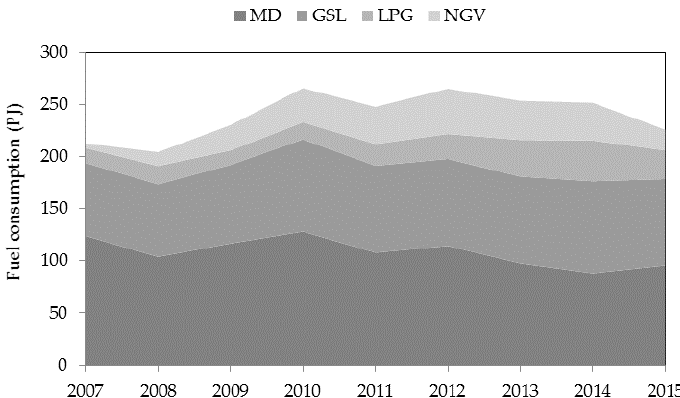
Figure 3. Fuel consumption of on-road transport activity in the BMR area from 2007 to 2015. Remark: MD stands for diesel (including HSD, HSD-B5, and LSD); GSL stands for gasoline fuel (including ULG-RON 91, ULG-RON 95, gasohol E10-RON 91, gasohol E10-RON 95, gasohol E10-RON 95, and gasohol E85),